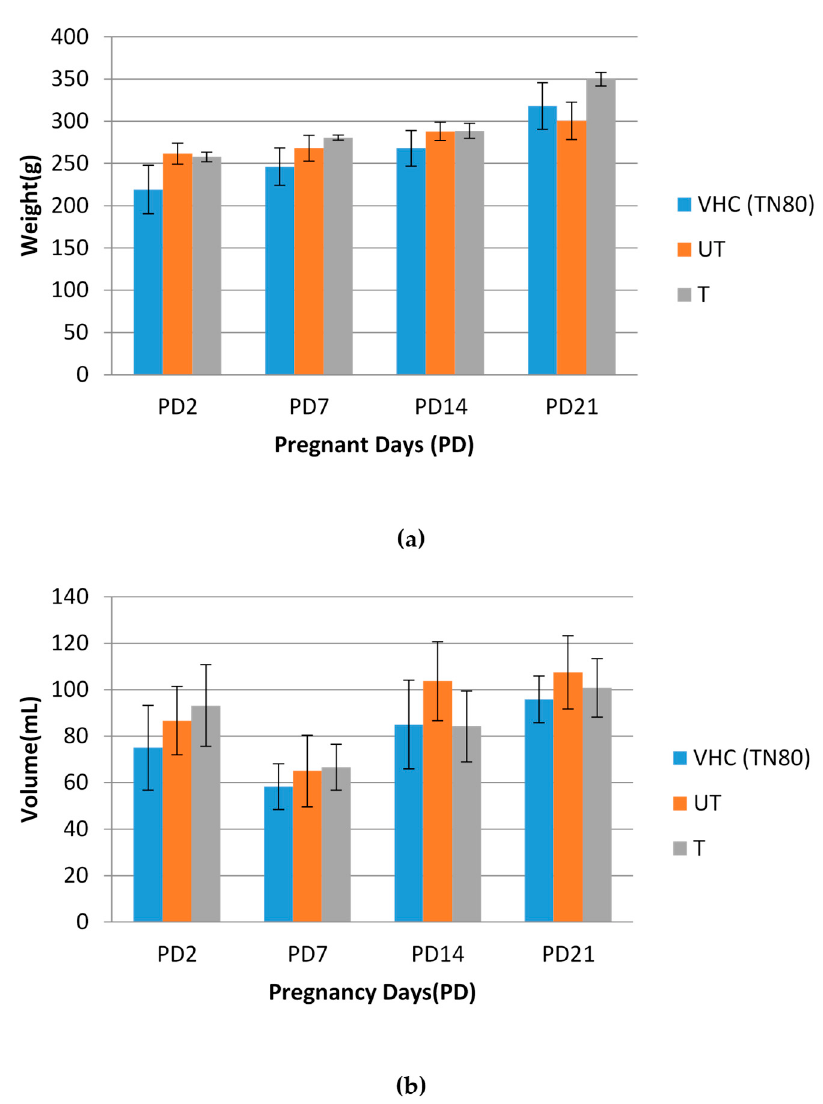
Figure 6. Effects of BPA on general health status of rats: ( a ) body weight of rats (wt); ( b ) drinking pattern of rats. Data are expressed as means. ( n = 4–6 rats per group). VHC (TN80): Vehicle Control Group Tween 80; UT: Untreated BPA water; T: Treated BPA water.